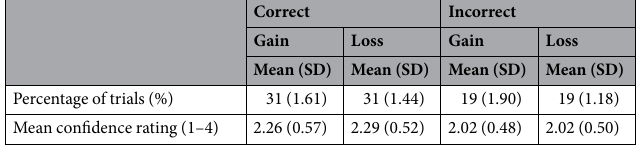
Table 1. Mean occurrence of each trial type with standard deviations in parentheses.